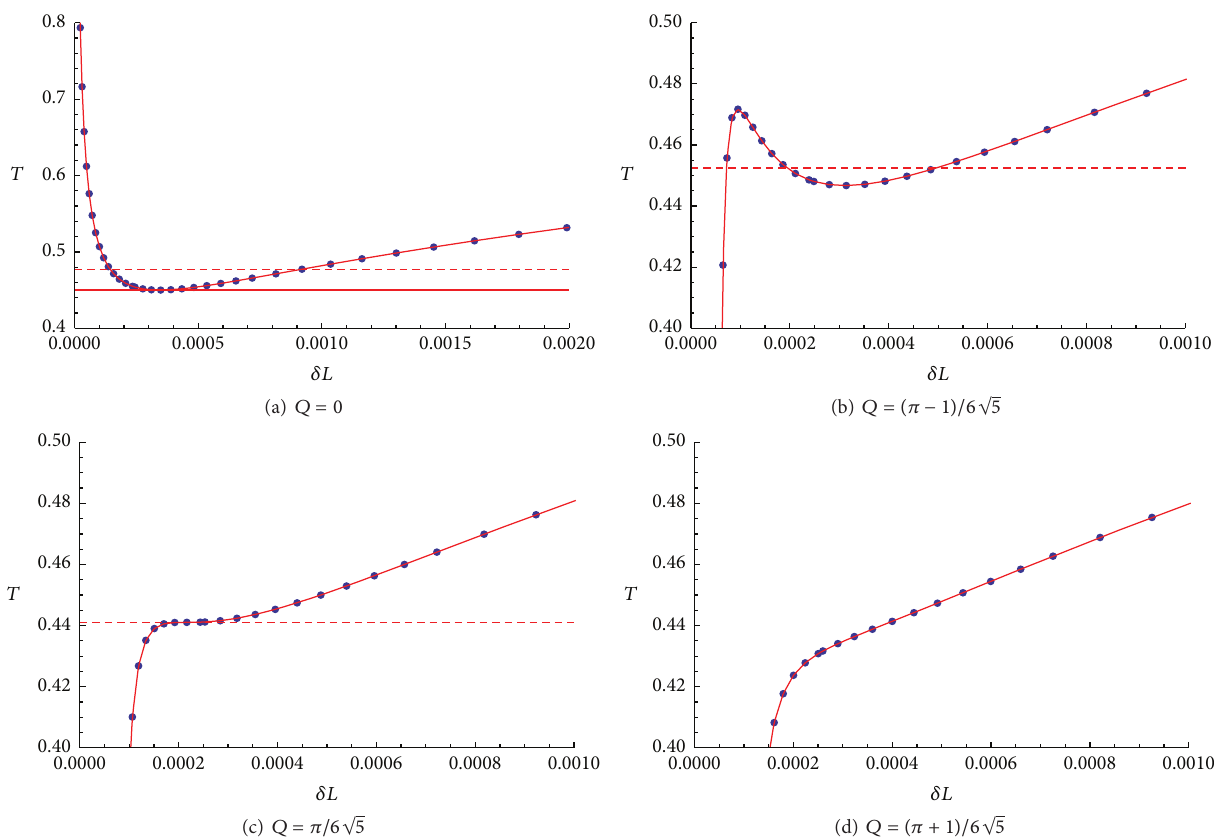
Figure 3: Relation between the geodesic length and temperature in the fixed charge ensemble for different charges at 𝜃 0 = 0.14 . The red solid line corresponds to the location of the minimum temperature 𝑇 0 ; the dashed lines in (a), (b), and (c) correspond individually to the locations of Hawking-Page phase transition 𝑇 1 , first-order phase transition 𝑇 ⋆ , and second-order phase transition 𝑇 𝑐